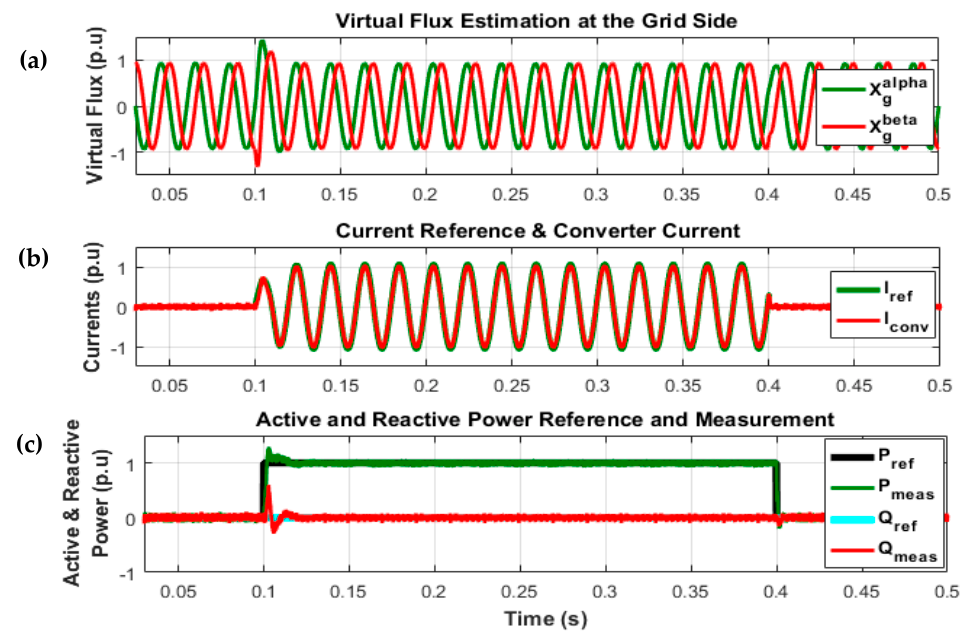
Figure 12. Simulation results: ( a ) VF estimation at the PCC; ( b ) Current reference generation and converter current; ( c ) Active & reactive power reference and measurement.